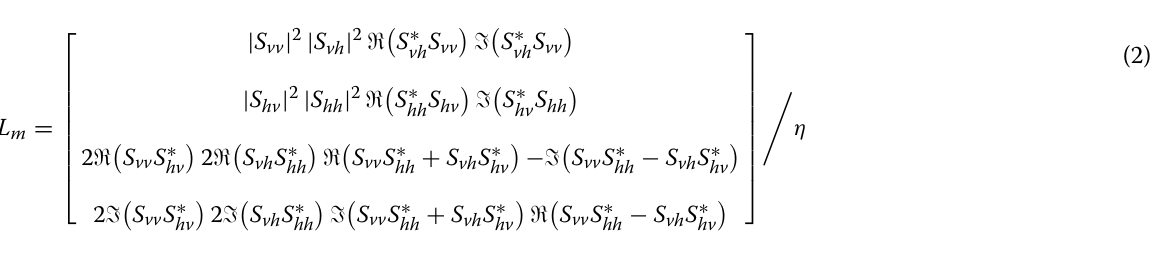
Scattering mechanisms There are 8 scattering mechanisms in the MIMICS model (Ferrazzoli et al. 2011; Ulaby et al. 1988). These include the direct specular scattering term (SG); the ran- dom rough surface term (DG); the direct crown bistatic scattering–ground reflection term (GCG); the